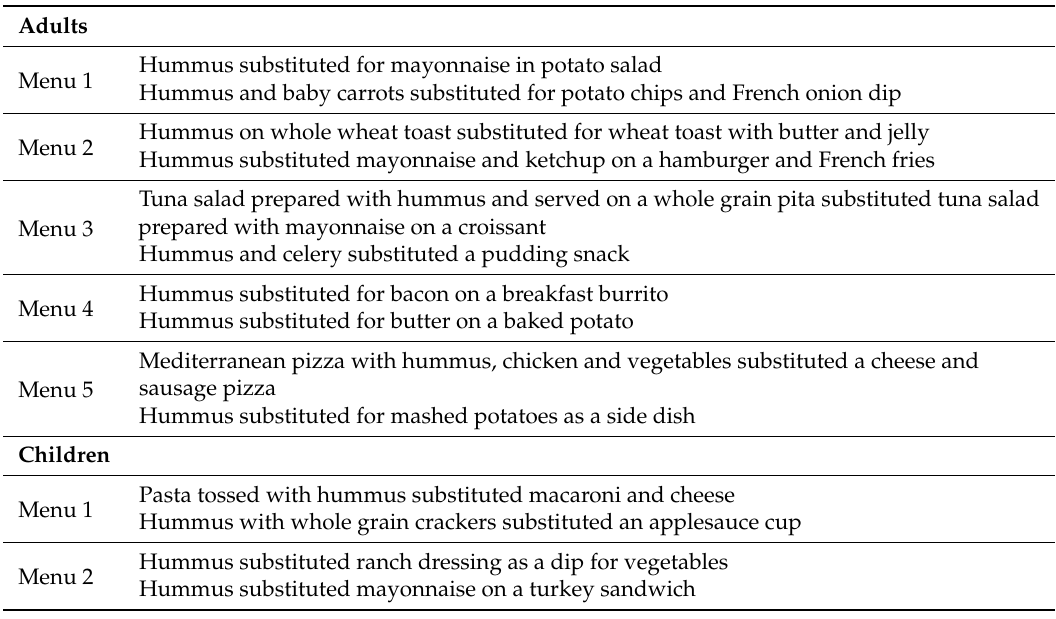
Table 3. Menu modeling examples of dietary improvements by substituting other dips, spreads, and ingredients with